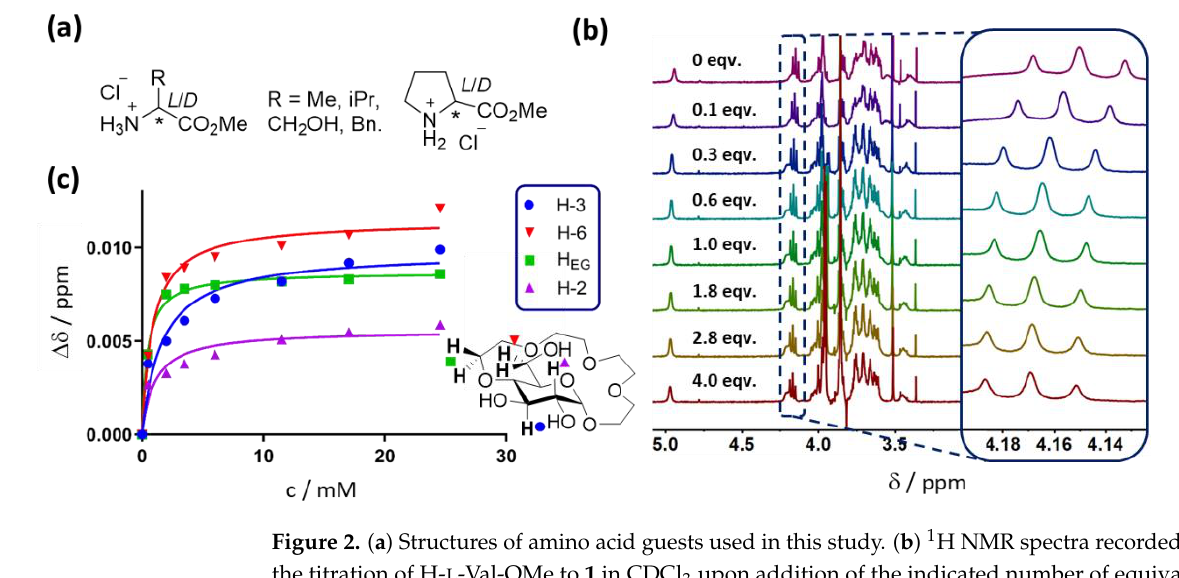
Figure 2. ( a ) Structures of amino acid guests used in this study. ( b ) 1 H NMR spectra recorded during the titration of H- L -Val-OMe to 1 in CDCl 3 upon addition of the indicated number of equivalents of guest (inset shows the shifting of H-3 glucopyranose protons in 1 during the titration)—shown as a representative example. ( c ) Titration curves obtained from the 1 H NMR data shown in ( b ). Table 1. Association constants of complexes between receptor 1 and amino acid methyl ester HCl salts 1